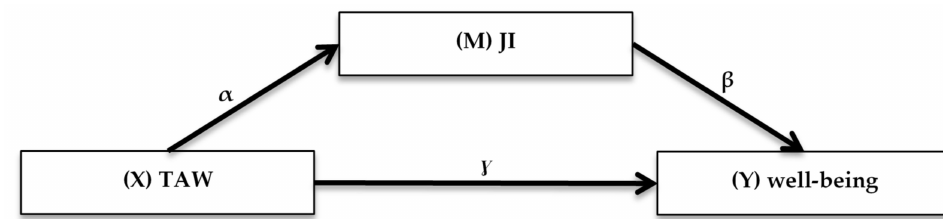
Figure 1. Mediation model.